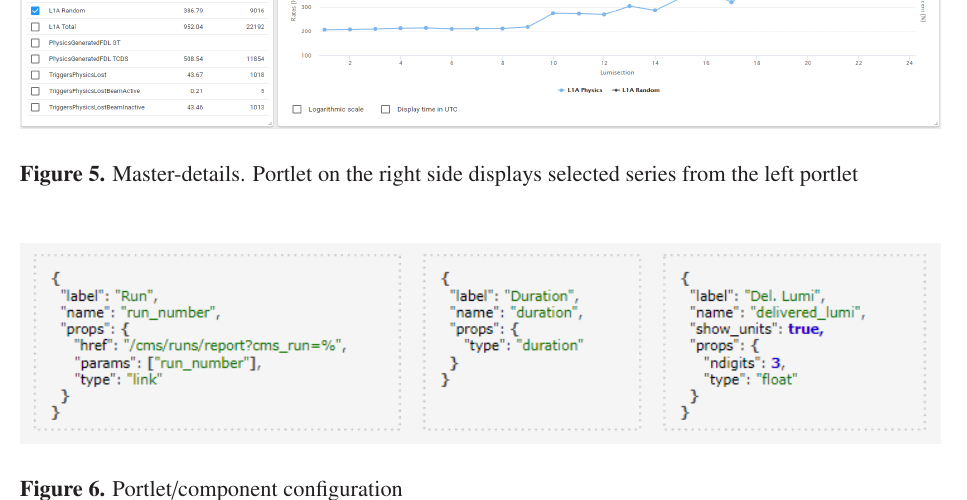
Figure 4. Integrated Luminosity Chart. First bar - start of LHC stable beam, sequent bars - downtimes, Figure 6. Portlet / component configuration black dashed lines - start of new CMS runs Table 3. List of main generic OMS components (around 20 in total as of paper publication